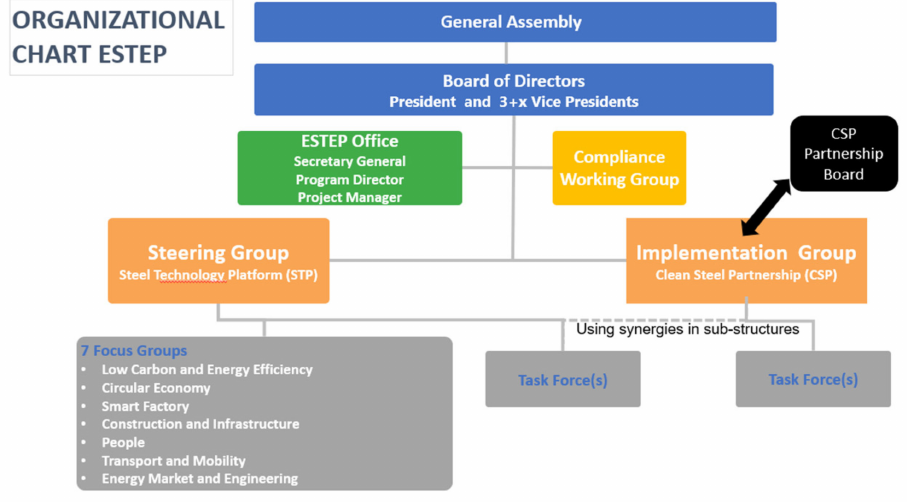
Figure 1. Organizational structure of ESTEP